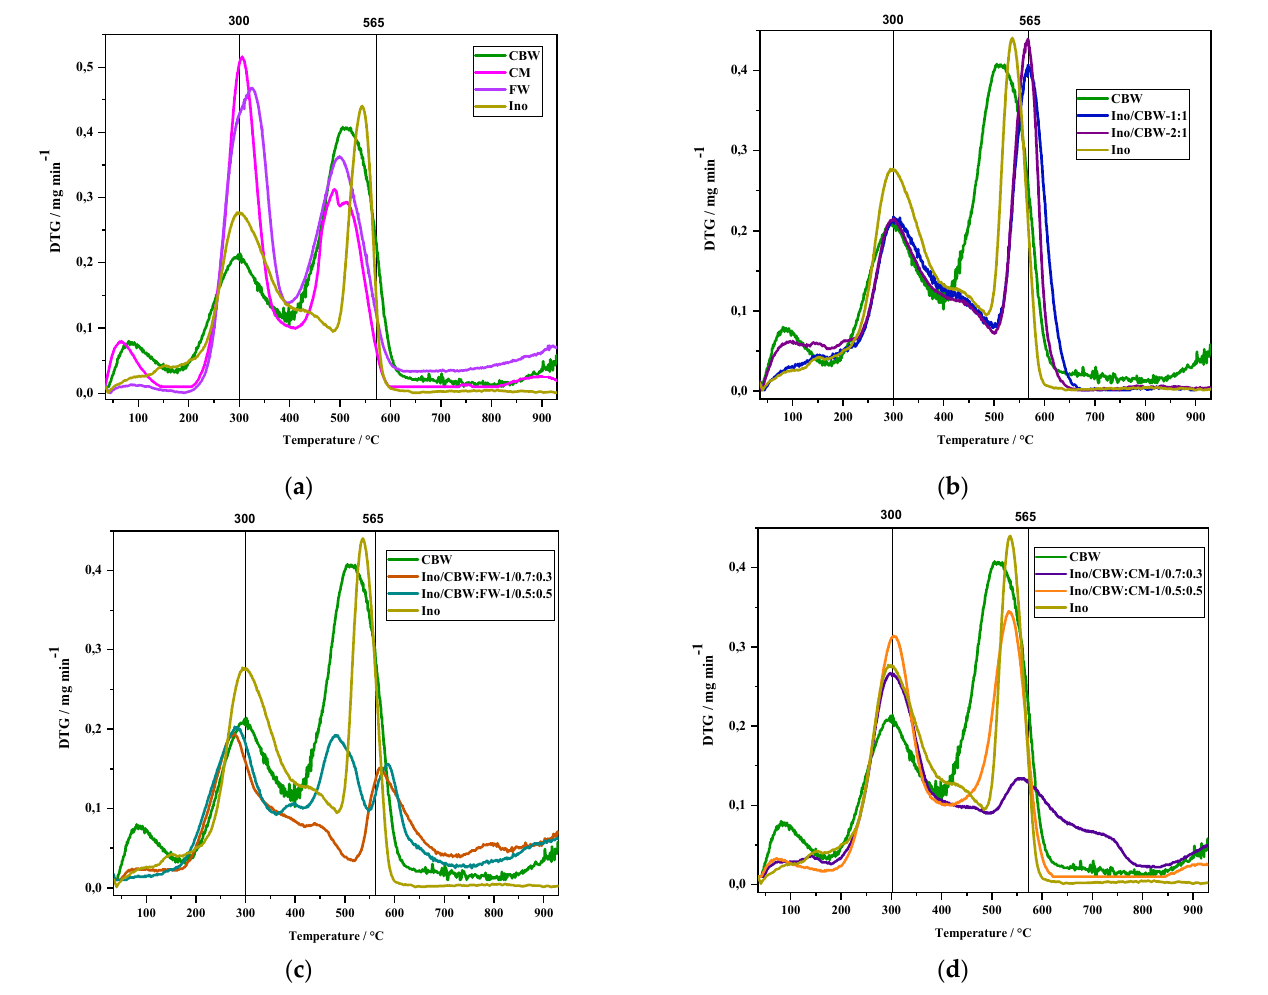
Figure 4. Differential thermal analysis. ( a ) Cork boiling wastewater (CBW), cow manure (CM), food waste (FW), and inoculum (Ino); ( b ) AD of different ratios of mixture of inoculum and cork boiling wastewater (Ino/CBW); ( c ) anaerobic digestion of different ratios of mixture of inoculum, cork boiling wastewater, and food waste (Ino/CBW:FW); ( d ) anaerobic digestion of different ratios of mixture of inoculum, cork boiling wastewater, and cow manure (Ino/CBW:CM).